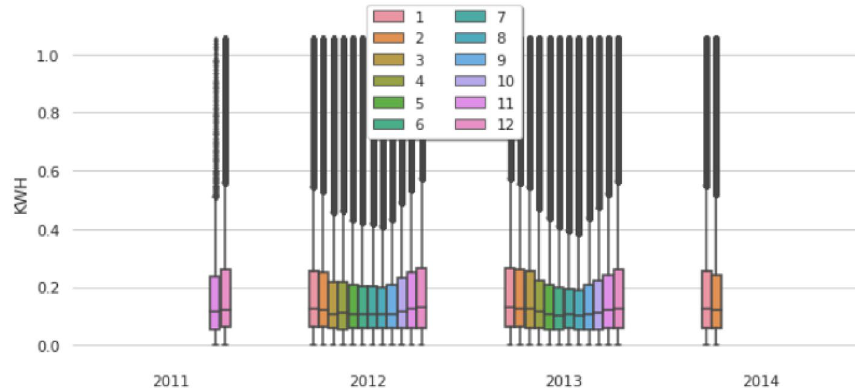
Fig. 12 Diagram of average monthly consumption